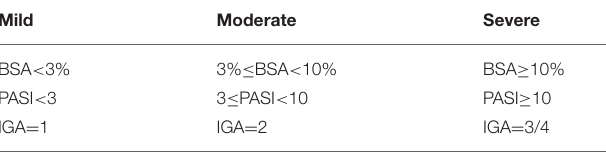
TABLE 1 | The severity of cutaneous psoriasis. Mild